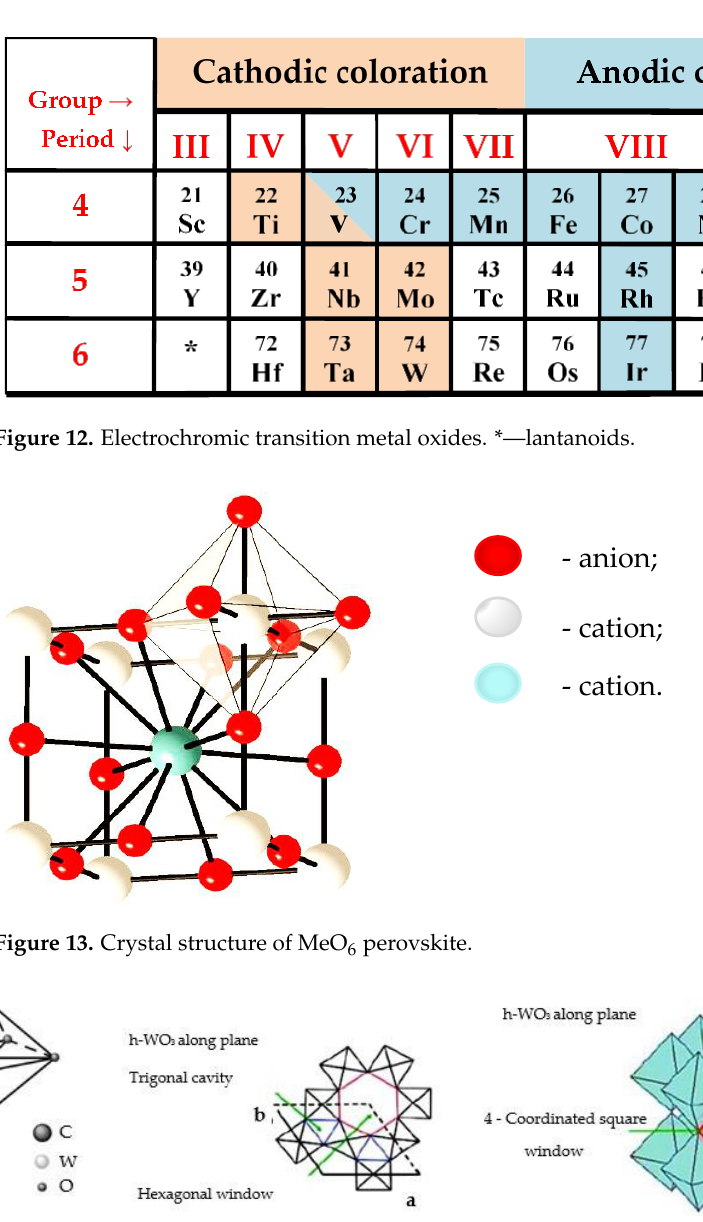
Figure 13. Crystal structure of MeO 6 perovskite.